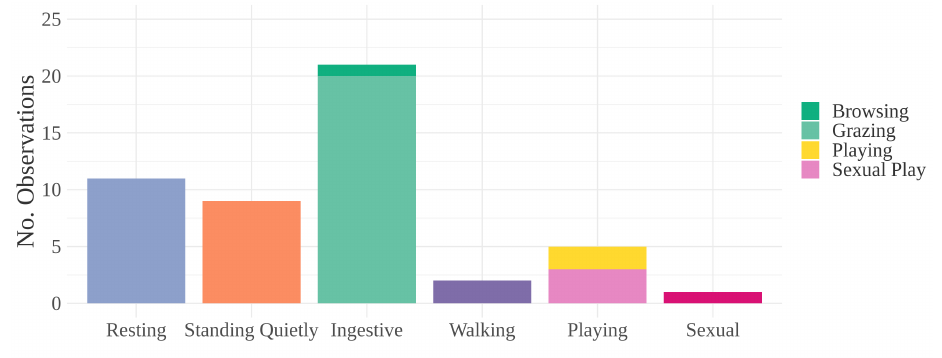
Figure 5. Behaviors observed concurrently with E/M bout. “Ingestive” includes browsing and grazing. “Playing” includes locomotive play (40%) and sexual play (60%). Arousal levels increase along the x -axis from left to right.